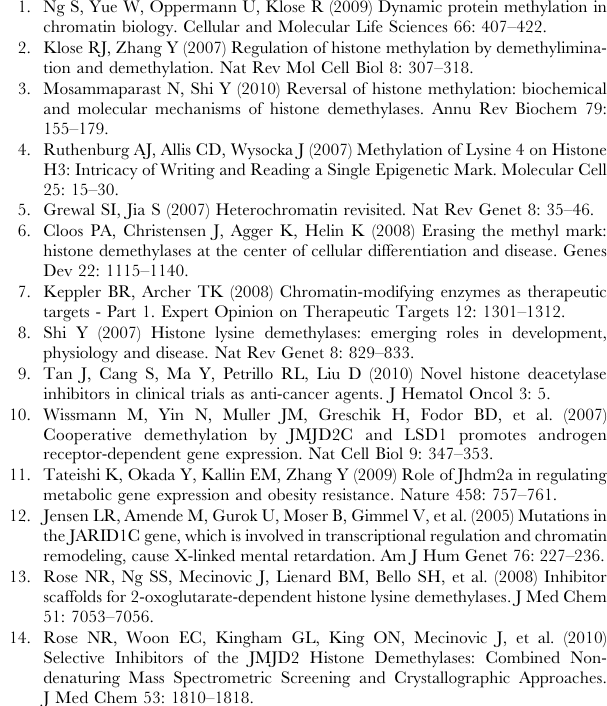
staining (blue) for DNA in HeLa cells overexpressing Flag-tagged